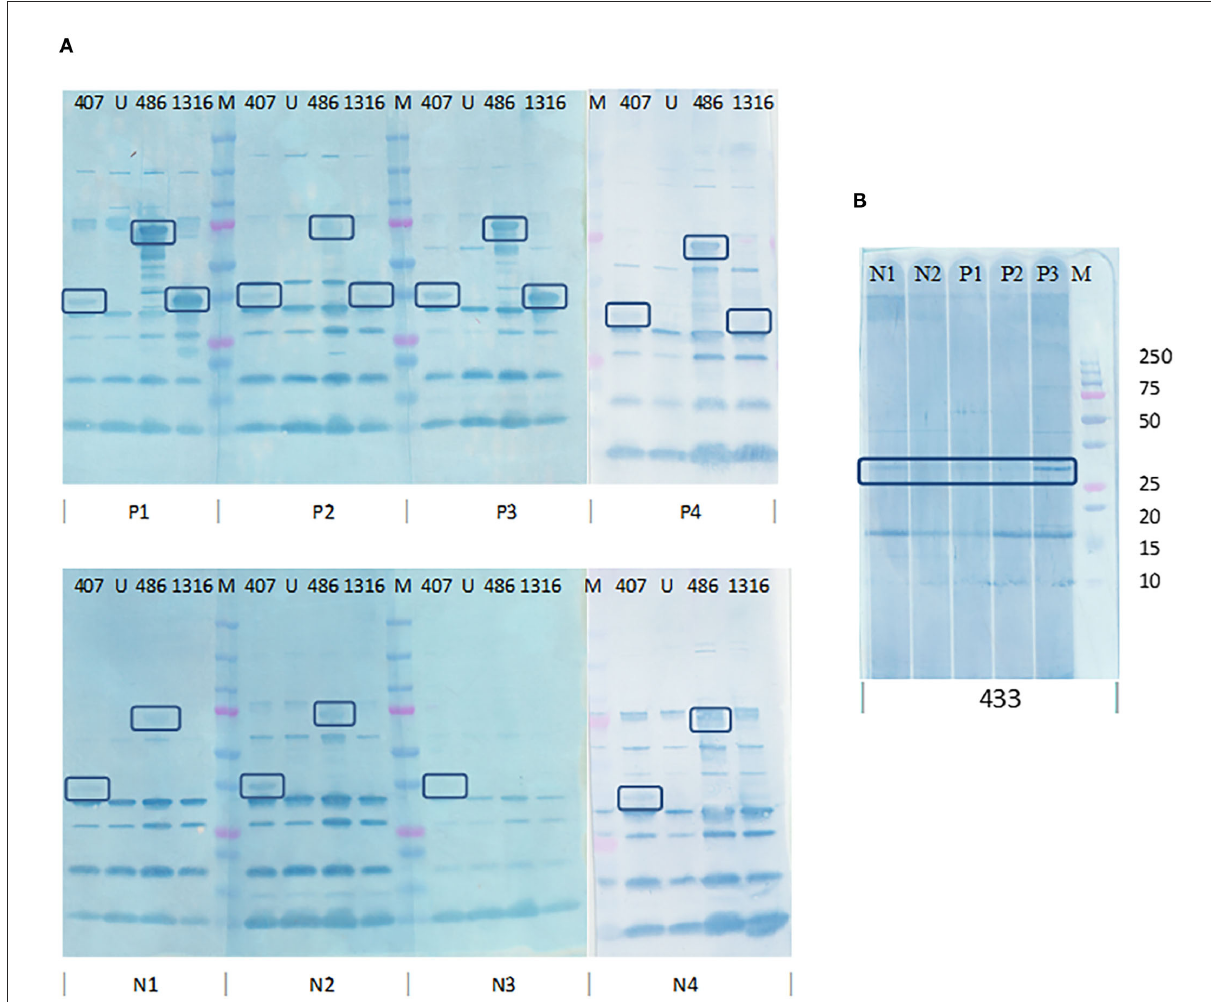
FIGURE4 Determination of C. hepaticus specific immunogenicity of the recombinant proteins coded by PEGs 407, 433, 486, and 1,316 by western blotting using individual SLD positive and negative sera. (A) PVDF membrane blotted with E. coli cell lysates (PEGs 407, 486, and 1,316) and probed with sera from four SLD positive birds, P1, P2, P3, and P4 and four negative control birds, N1, N2, N3, and N4. (B) PVDF membrane blotted with E. coli cell lysate (PEG 433) and probed with sera from three SLD positive birds, P1, P2, and P3, and two negative control birds, N1 and N2. Only the recombinant protein encoded by PEG 1,316 showed C. hepaticus specific immunogenicity as it was recognized by SLD positive sera and not by the negative control sera. The recombinant proteins encoded by PEGs 433, 407, and 486 cross reacted with antibodies in several SLD negative sera. M–Precision plus protein ladder